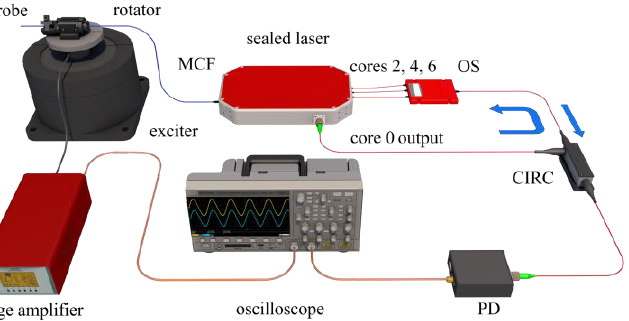
Figure 3. Schematic diagram of the experimental setup for the vector vibration detection system.